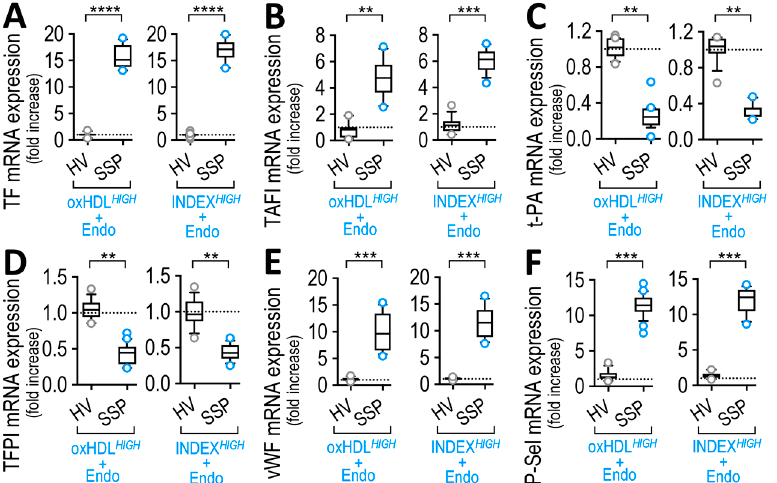
Figure 9. Coagulation factors and platelet adhesion protein mRNA expression in cultured EC exposed to exogenous SSP plasma preparation. Exogenous plasma preparation of SSP high- and low-oxHDL were designed using the median concentration of oxHDL measured in plasma obtained from high- and low-oxHDL groups (SSP-oxHDL HIGH +Endo and SSP-oxHDL LOW +Endo). Exogenous plasma preparation of SSP high- and low-INDEX were designed using the concentration of oxHDL and HDL measured in the median INDEX value determined in plasma obtained from high- and low-INDEX groups (SSP-INDEX HIGH +Endo and SSP-INDEX LOW +Endo). Exogenous plasma preparation from HV was designed combining a proper amount of HDL and oxHDL but without endotoxin (HV-oxHDL and HV-INDEX). Normalized mRNA expression of TF ( A ), TAFI ( B ), t-PA ( C ), TFPI ( D ), vWF ( E ) and P-Sel ( F ) were measured in EC cultures exposed to SSP-oxHDL HIGH +Endo (left panels) and SSP-INDEX HIGH +Endo (right panels) exogenous SSP plasma preparation. Statistical dif- ferences were assessed with student’s t-test (Mann–Whitney). ** p < 0.01, *** p < 0.001, **** p < 0.0001 Values are expressed as the median ± 10-90 percentile. Dotted line depicts normalized expression obtained in non-treated EC cultures.